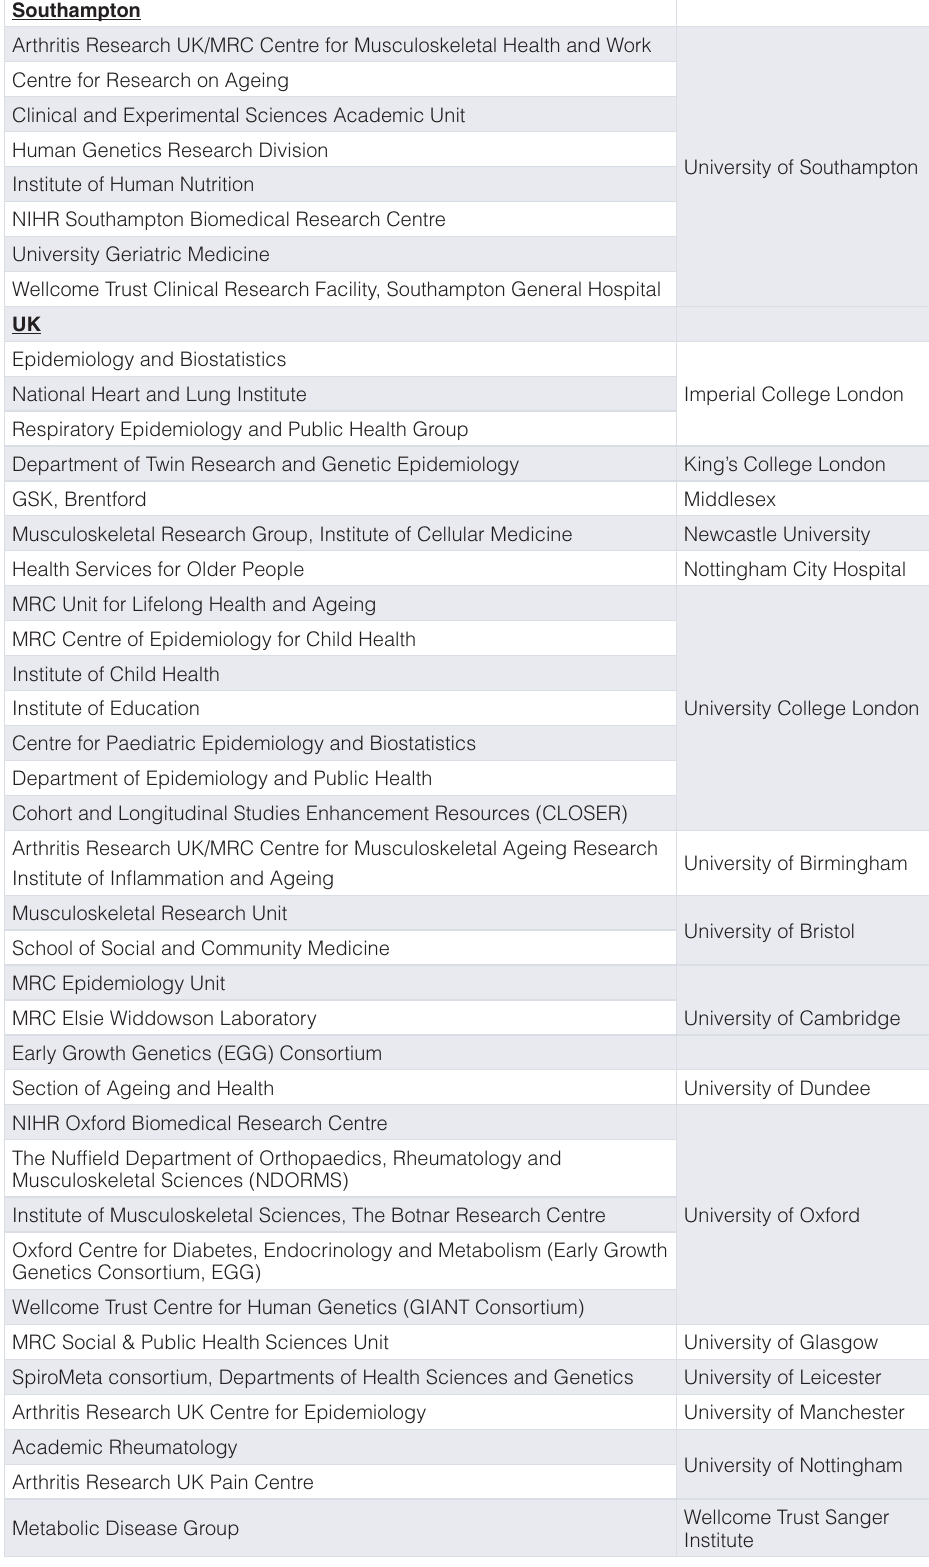
Table 13. Location of principal Hertfordshire Cohort Study collaborators: local, national and international.